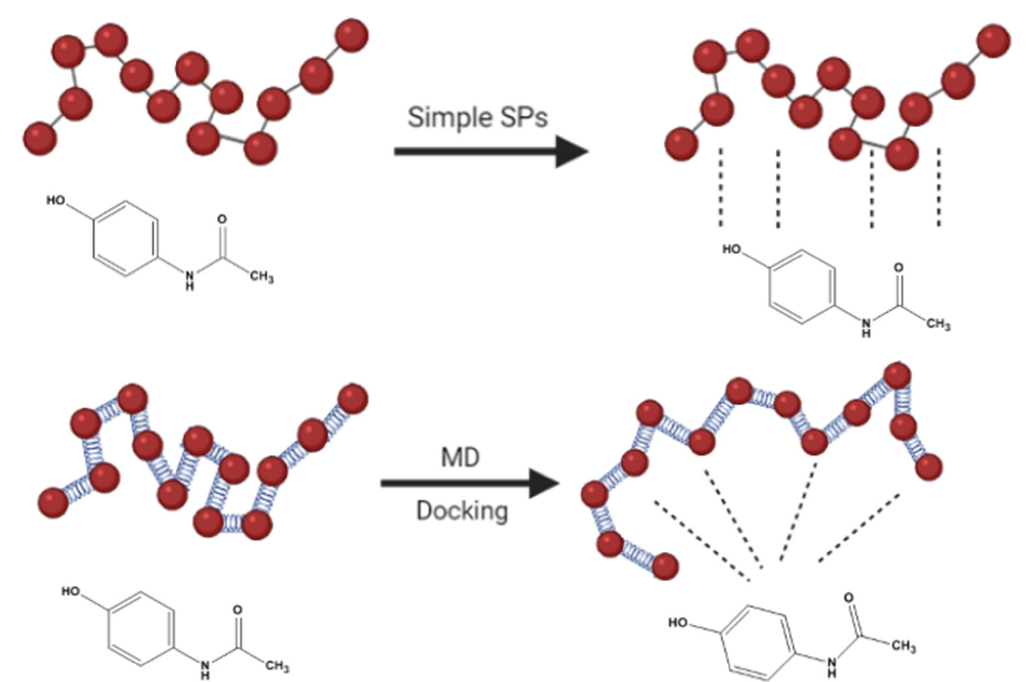
Figure 2. Schematic presentation to contrast classical drug-carrier interaction (solubility parameters) with the modern 3D representation (molecular dynamics and molecular docking).